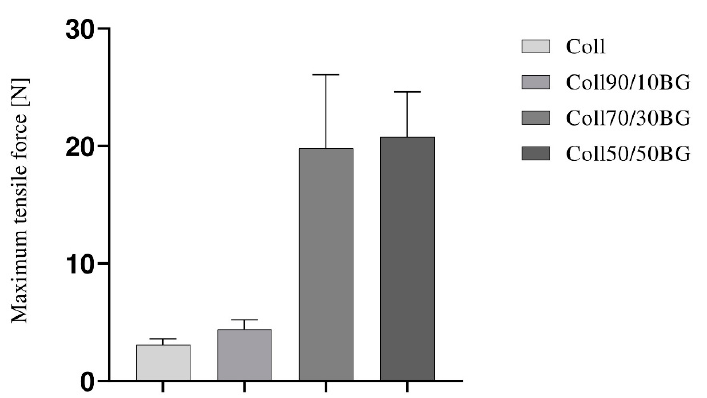
Figure 2. Maximum tensile force at break for the films based on collagen and β -glucan in the weight ratios: 100/00, 90/10, 70/30, and 50/50.